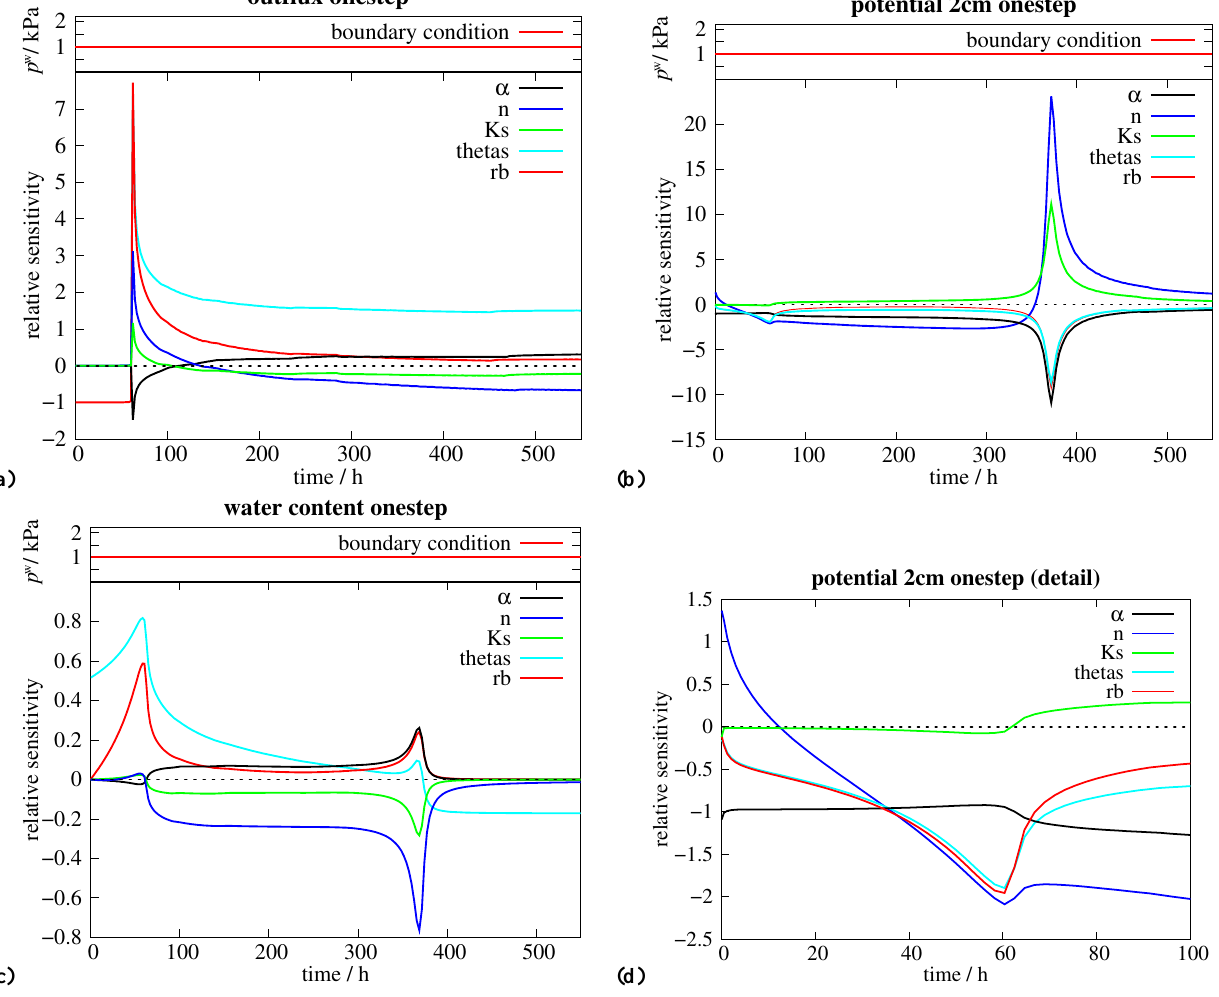
Fig. 6. Sensitivity coefficients s(t) for the onestep experiment for the outflux (a) , the potential in 2cm (b) and the water content in 2cm (c) . A detail view of the first 100h for the potential in 2cm is shown in (d) . Notice that p w jumps from equilibrium to 1kPa at t =